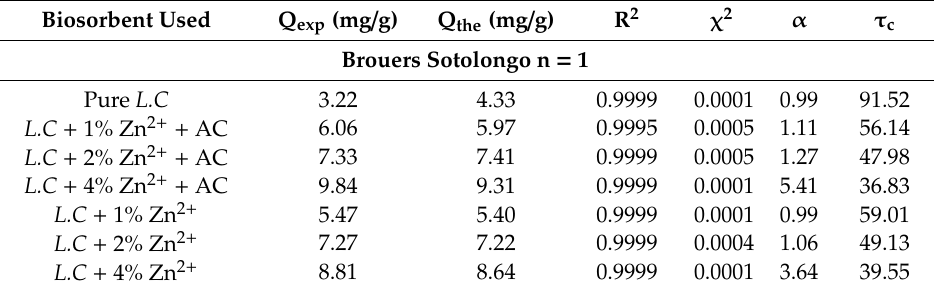
Table 4. Comparative results for the B.S